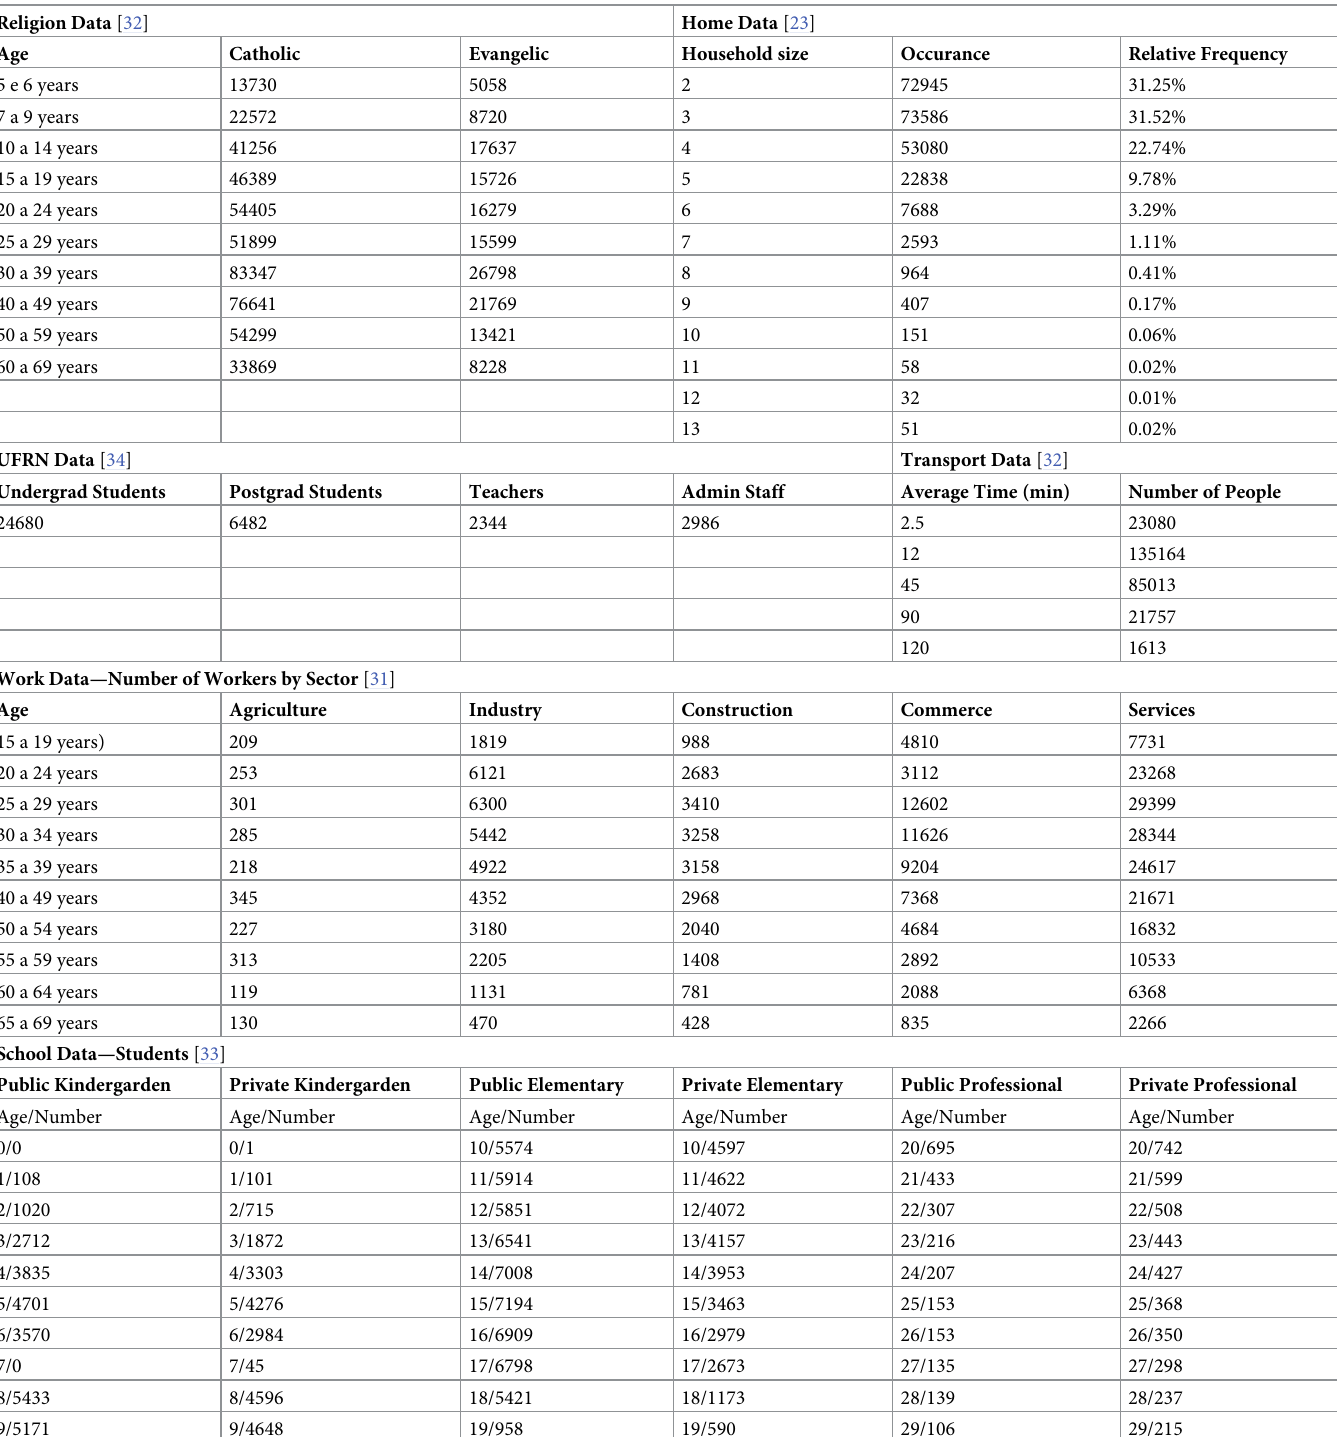
Table 1. Demographic data used for the model and their